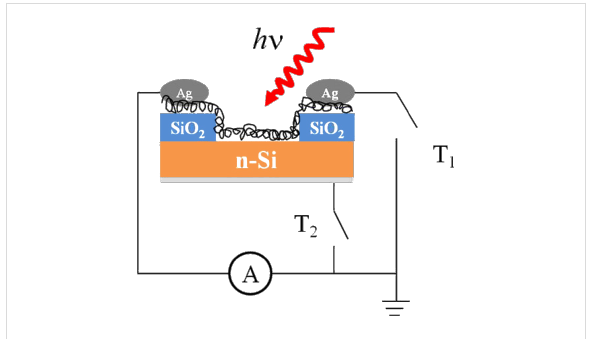
Figure 8: Scheme of the photovoltaic device. The Schottky junction between the Si and the MWCNT film is the photoactive junction. Steps of SiO 2 (300 nm) are used to avoid a short-circuit forming between the silver paint (top electrode) and the silicon substrate. The back contact is made of aluminium. In the in-plane geometry, the switch T1 is on and T2 is off; and vice versa in the top-down configuration. As a result, the photocurrent is collected at the MWCNT film in the former case, and at the MWCNTs and Si (back contact) in the